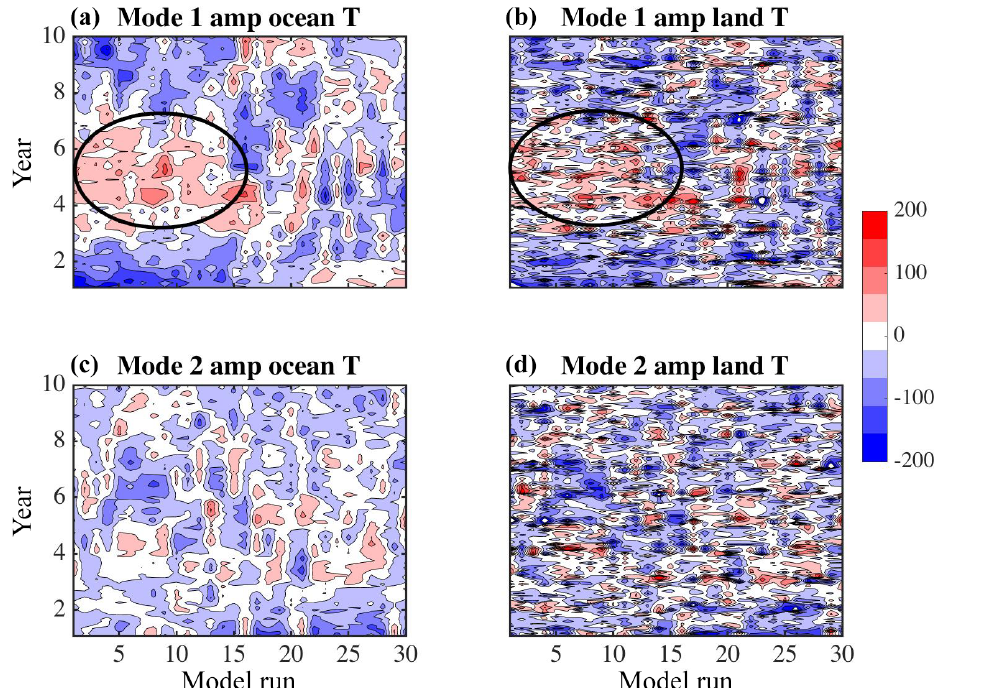
Figure 7. Time series for MCA analysis associated with maps in Fig. 5 for modes 1 (a) and 2 (b) , with ocean time series in column 1 and land time series in column 2. The model numbers are along the x axis with time on the y axis. The ellipses are used for identifying a region of interest in the